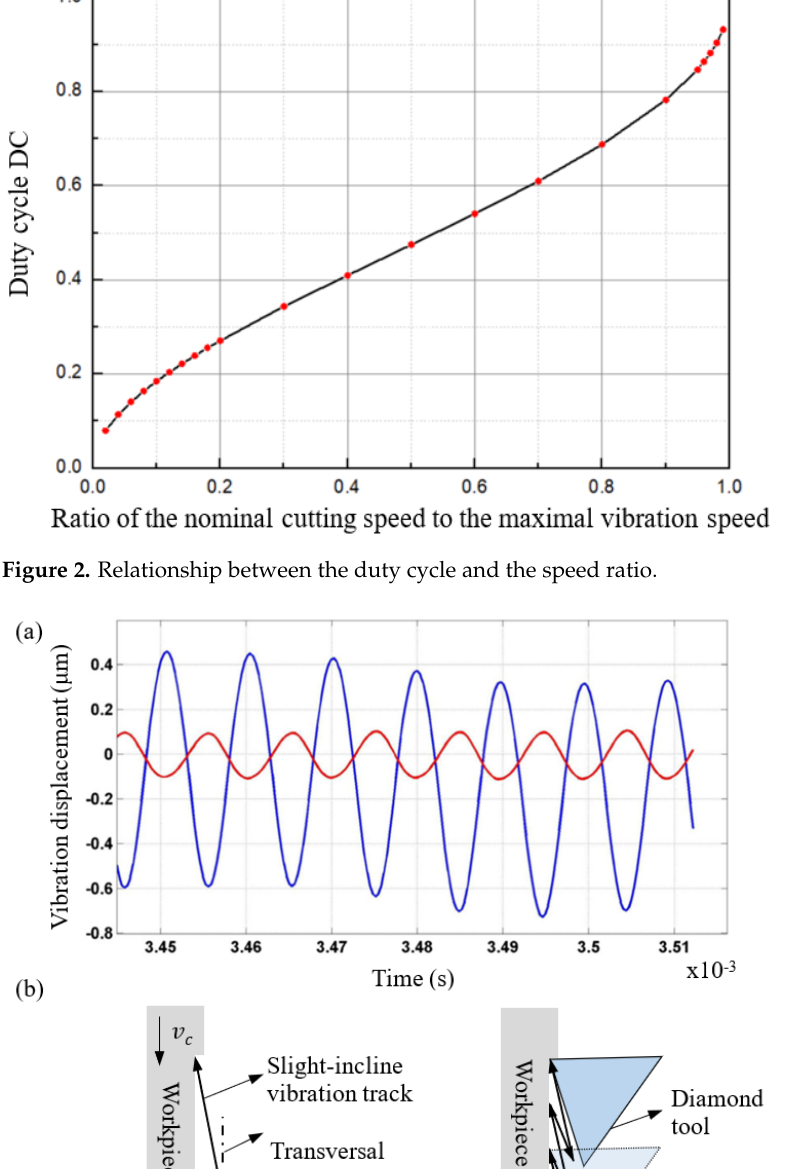
Figure 4a,b show diagrams of a concave and convex spherical mould,